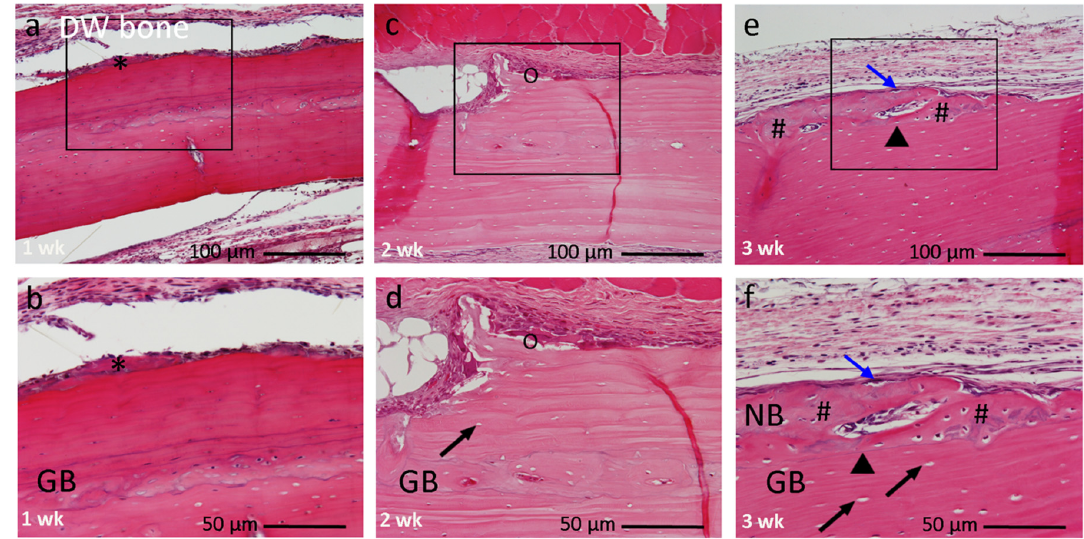
Figure 5. Histological image of DW bone group at 1, 2, 3 weeks after implantation, at higher magnification. ( a , b ) At 1 week grafted bone encapsulated by a thin layer of connective tissue (*). ( c , d ) At 2 weeks progression of excavation chamber with multinucleated giant cells (O). ( e , f ) At 3 weeks localized woven bone induction (#) along outer cortical plate clearly separated by a cement line ( ). Box within a, c, e indicates the focused areas in ( b , d , f ), respectively. ( a , b ) 1 week, ( c , d ) 2 weeks, ( e , f ) 3 weeks. Magnification: ( a , c , e ) 10 × , ( b , d , f ) 20 × . ( (cid:37) ) = empty lacunae, ( (cid:38) ) = early active cuboidal osteoblast cell differentiation, GB: graft bone, NB: new bone. Bar: ( a , c , e ) 100 µ m; ( b , d , f ) 50 µ m.